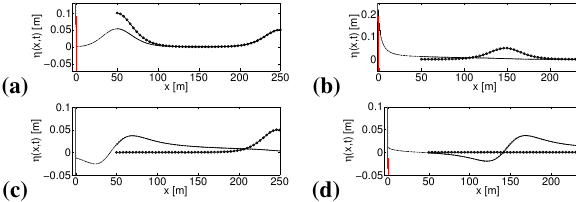
Fig. 9. Free-surface profiles of solitary wave propagation are shown Figure 9. Free-surface profiles of solitary wave propagation are for the coupled LSWE with the NSWE (dashed and dotted-dashed shown for the coupled LSWE with the NSWE (dashed and dotted- lines), for the LSWE with an EBC implementation (solid line), and dashed lines), for the LSWE with an EBC implementation (solid for the LSWE with the method of Choi et al. (2011) (solid line with line), and for the LSWE with the method of Choi et al. (2011) ’o’ marker) at times (a) t = 10 s , (b) t = 20 s , (c) t = 30 s , (d) t = (solid line with the “o” marker) at times (a) t = 10s, (b) t = 20s, 40 s . The solid and dashed lines are on top of another. (c) t = 30s, and (d) t = 40s. The solid and dashed lines are on top of one another. 12